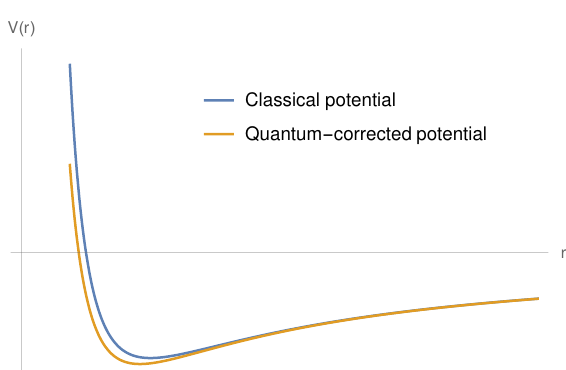
Figure 6. Qualitative comparison between the classical (post-)Newtonian gravitational potential and the quantum-corrected one, where the size of the quantum corrections is vastly exaggerated to be